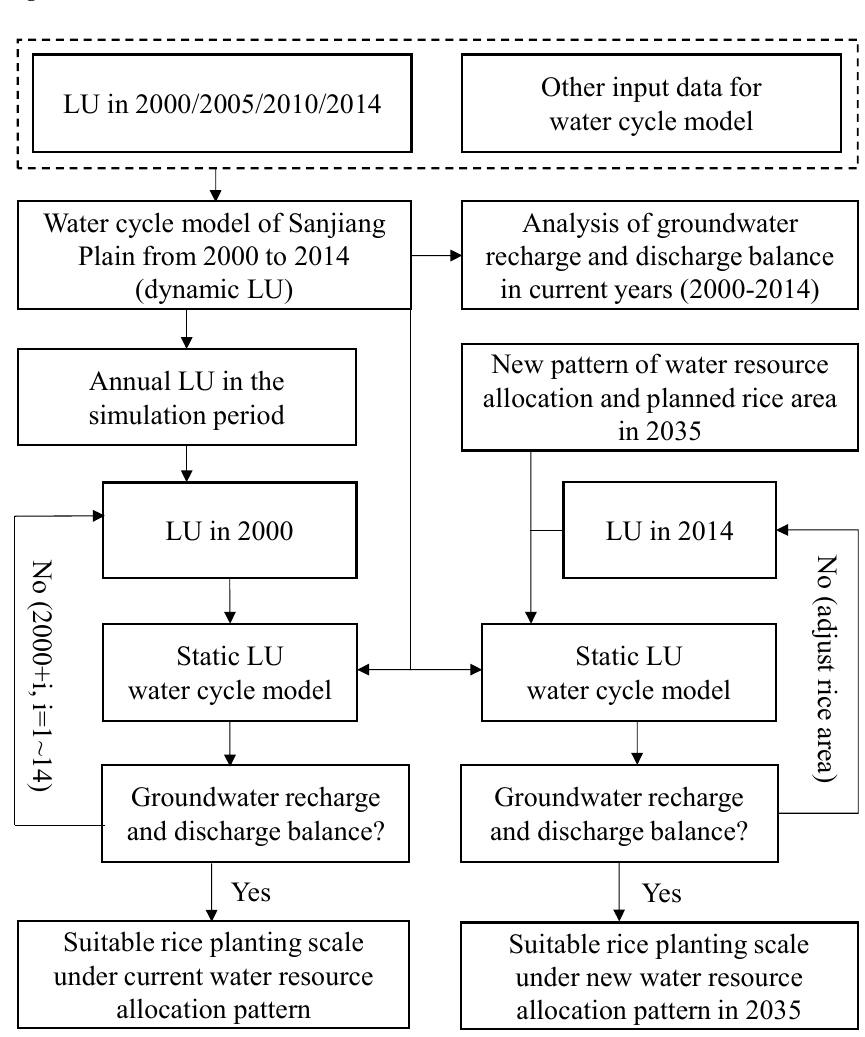
Figure 2. Flow chart of the technical scheme (LU: land use).